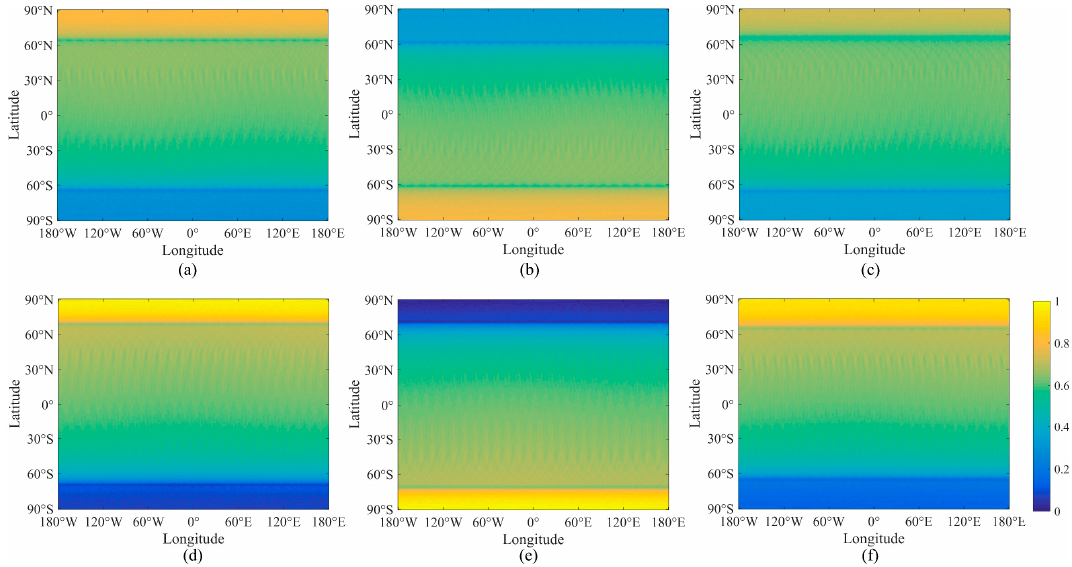
Figure 7. Global observation duration distribution from (0°,0°) on the lunar surface during ( a ) 2021, ( b )2025, ( c ) 2029, ( d ) 2031, ( e ) 2035, and ( f ) 2039.